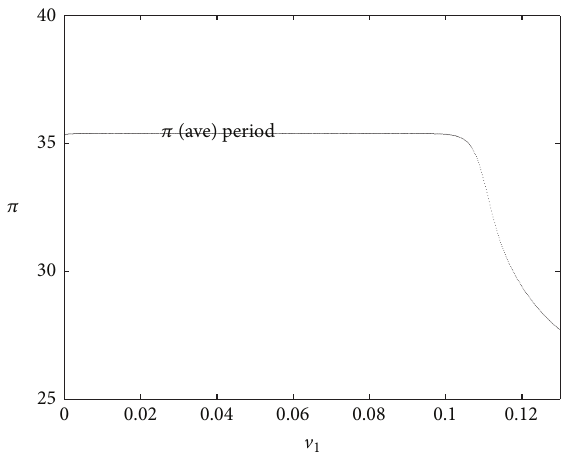
Figure 9: Average profit of the oligarchs with V 1 .